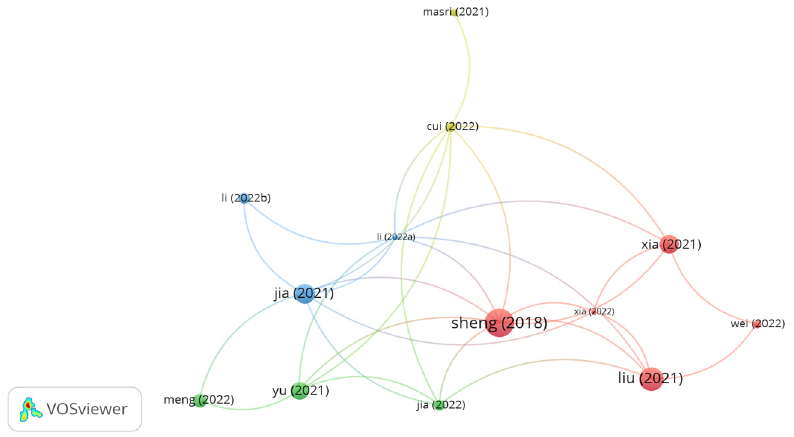
Figure 12. Network visualization of bamboo fibers.